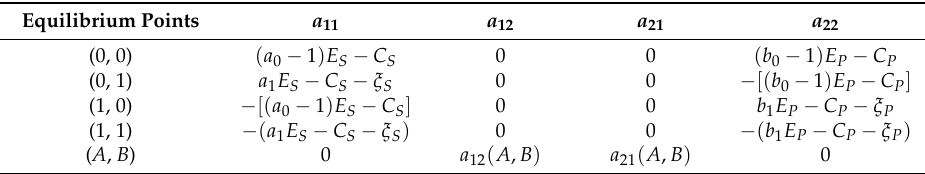
Table 3. Values of equilibrium